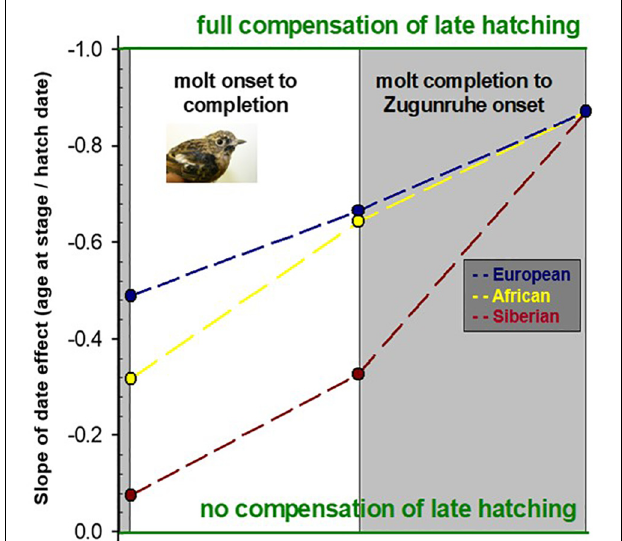
FIGURE 2 | Synchronization of autumn activities. The graph shows data from captive young stonechats from different populations that hatched at different times of year under naturally changing photoperiods. Stonechats from all populations compensated for late hatching by earlier start of molt, faster molt, and younger ages at initiating Zugunruhe. Shown are on the y -axis the slopes of age at the onset and end of molt, and at the start of Zugunruhe, against hatch date on the x -axis (from left to right). Based on Helm et al. (2005). Inlay: stonechat during postjuvenile